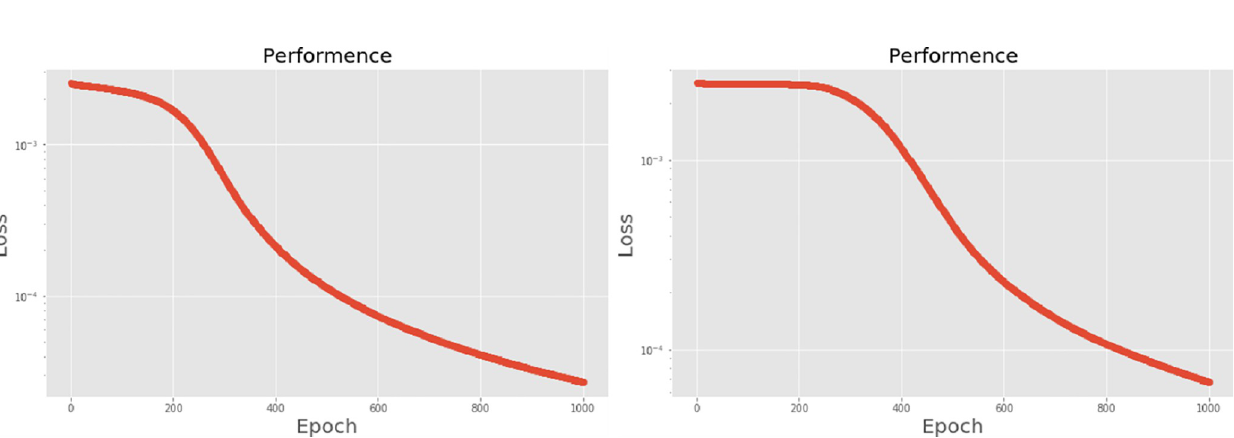
Fig 25. (a) The graph shows the performance of MFCC-LSTM-2 × 200 model; (b) The graph shows the performance of MFCC-PCA-LSTM-2 × 200 model.